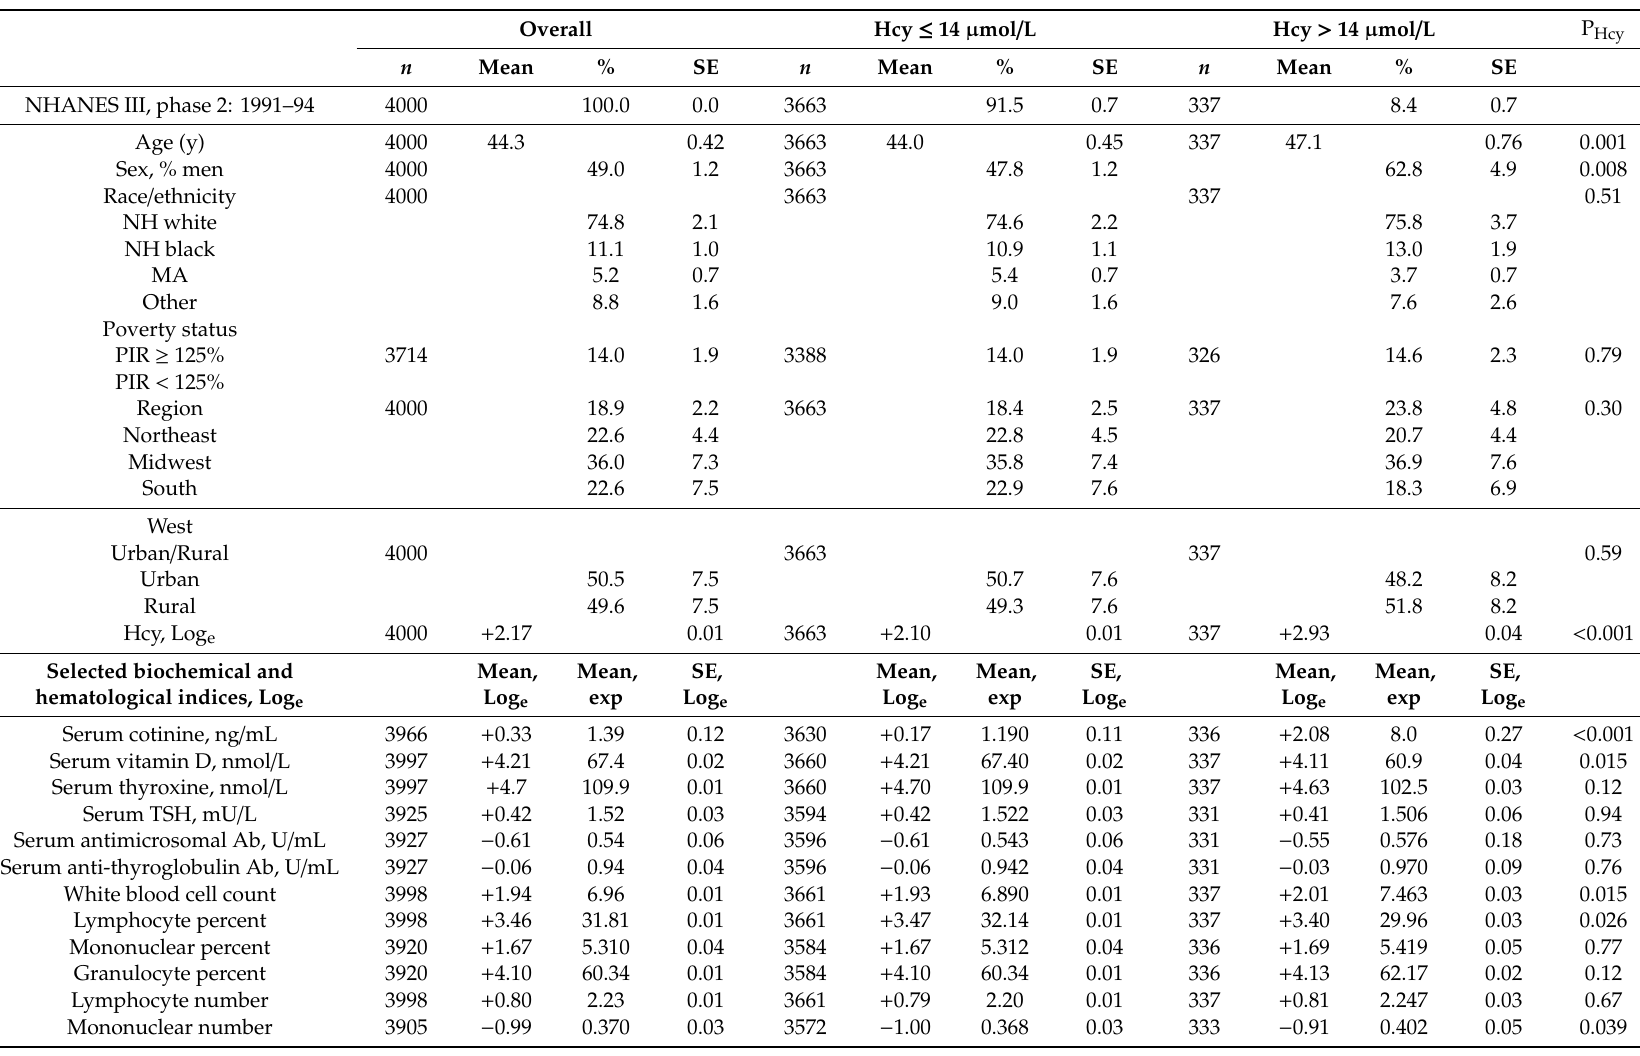
Table 1. Participant characteristics distribution by hyperhomocysteinemia status: NHANES III, phase 2; NHANES 1999–2006 and HANDLS 2004–2018 1